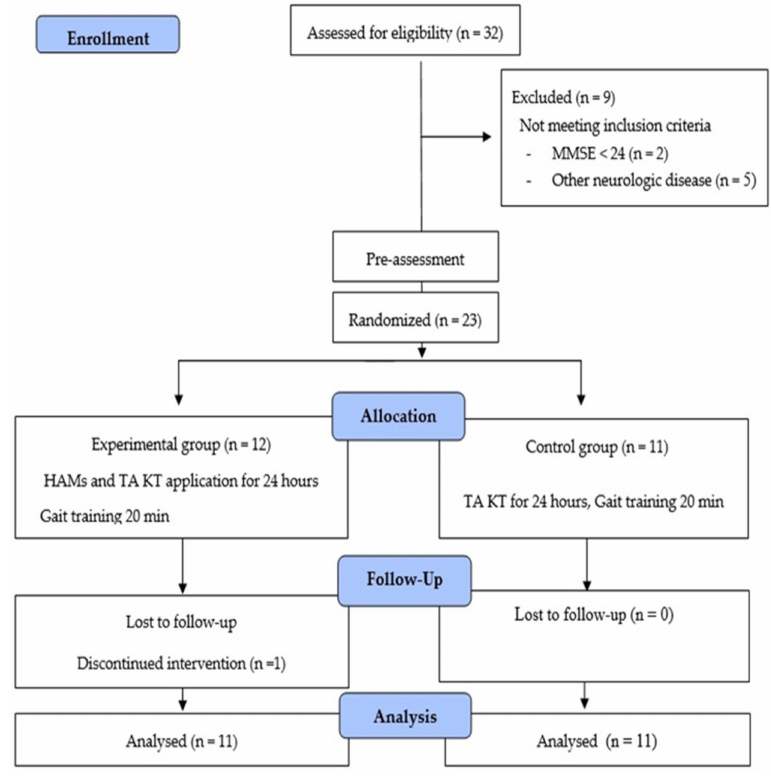
Figure 1. Flow chart of this